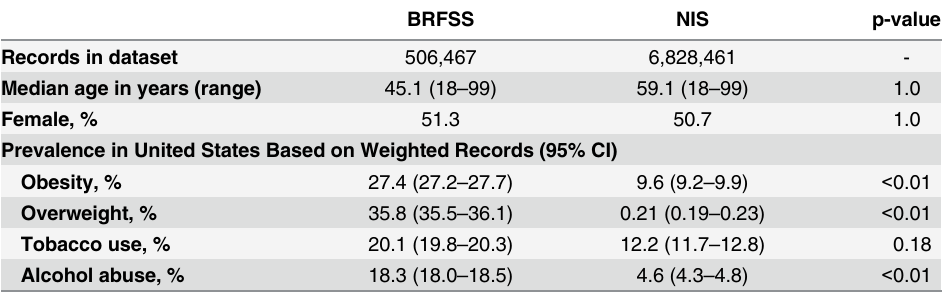
Table 2. Weighted BRFSS and NIS Demographic Characteristics and National Prevalence of Risk Fac- tors, 2011. BRFSS